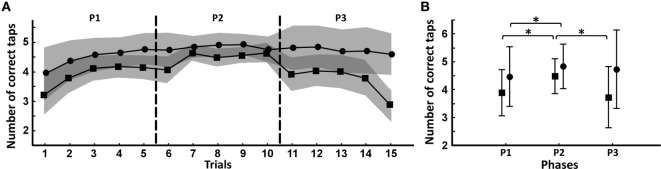
Evolution of performance during the sequential finger-tapping task. (A) Mean number of correct taps per trial across the 15 trials for the patient group (squares) and for the control group (circles). Vertical stippled lines indicate the three successive phases of the task. The SE of each group is represented by a gray area around the mean values (dark gray: overlap). (B) Mean number of correct taps for each phase consisting of five trials (P1: first half of the learning phase, P2: second half of the learning phase, P3: recall phase) in patient group (squares) and control group (circles). Horizontal lines represent within-group comparisons between P1/P2/P3. *Significant difference P < 0.05.